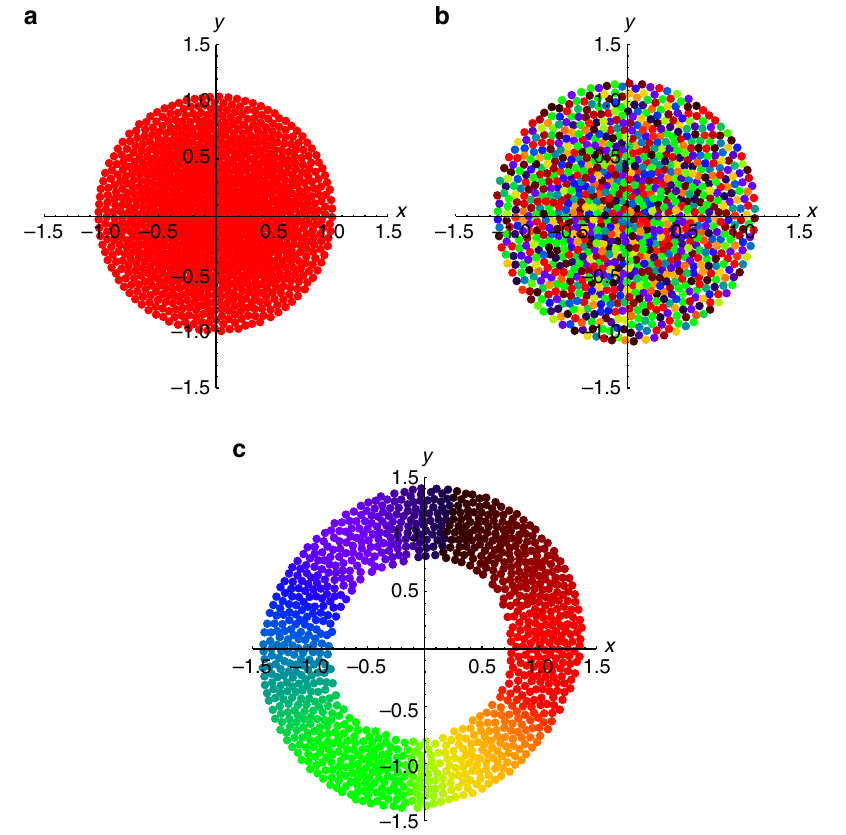
Fig. 2 Stationary states. Scatter plots of three states in the ( x , y ) plane, where the swarmalators are colored according to their phase. Simulations were for N = 1000 swarmalators for T = 100 time units and stepsize dt = 0.1. Supplementary Movies 1 – 3 correspond to panels a – c . a Static sync state for ( J , K ) = (0.1, 1). b Static async state ( J , K ) = (0.1, − 1). c Static phase wave state ( J , K ) = (1,